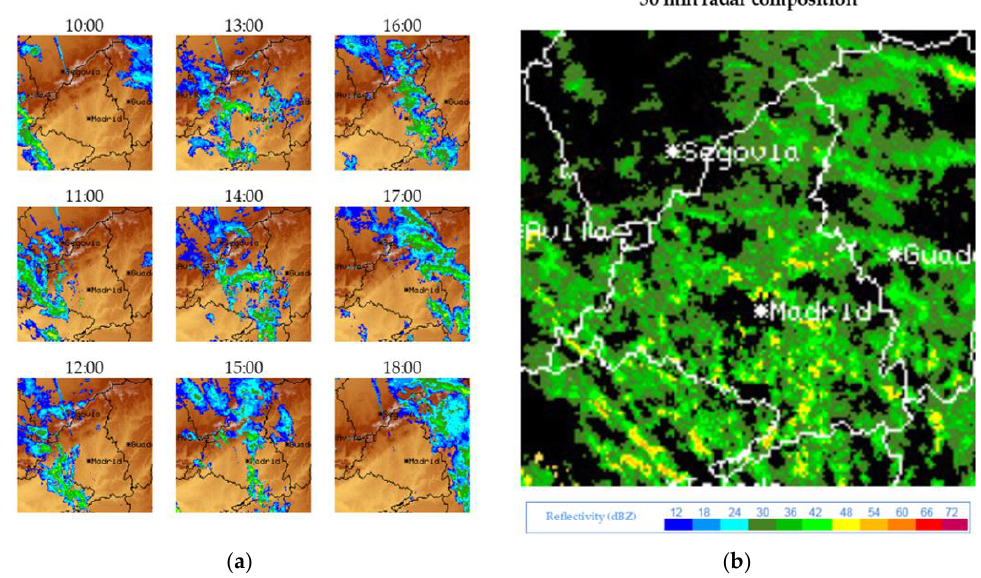
Figure 5. ( a ) Madrid radar reflectivity hourly images from 10:00 to 18:00 UTC and ( b ) composite image of radar reflectivity every 30 min in the same period. Images have been cropped. For the composite, terrain and reflectivity <30 dBZ were removed, and reflectivity values were divided into three ranges (30–42, 48–60, and 66–72 dBZ), prioritizing those of greater reflectivity. Thus, each grid point shows the largest reflectivity value shown over the period.